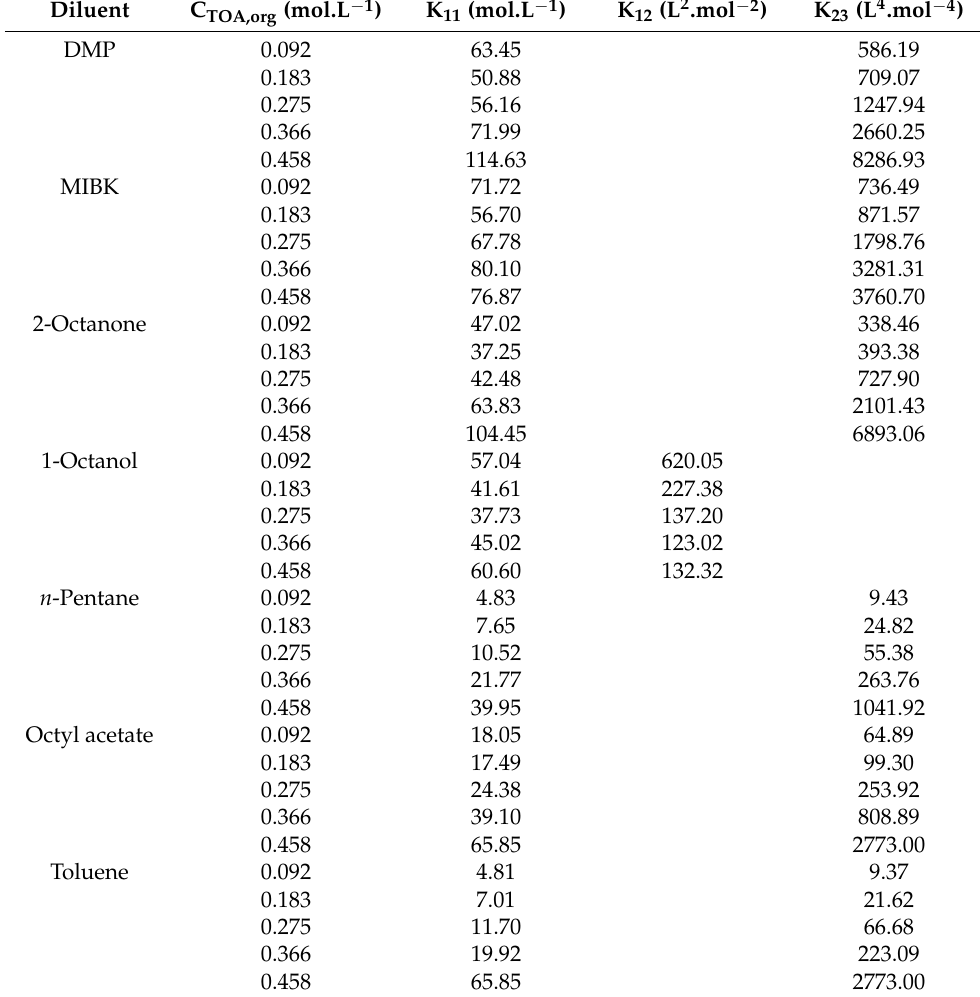
Table 3. The overall extraction constant values of K 11 , K 12 , and K 23 in different diluents.